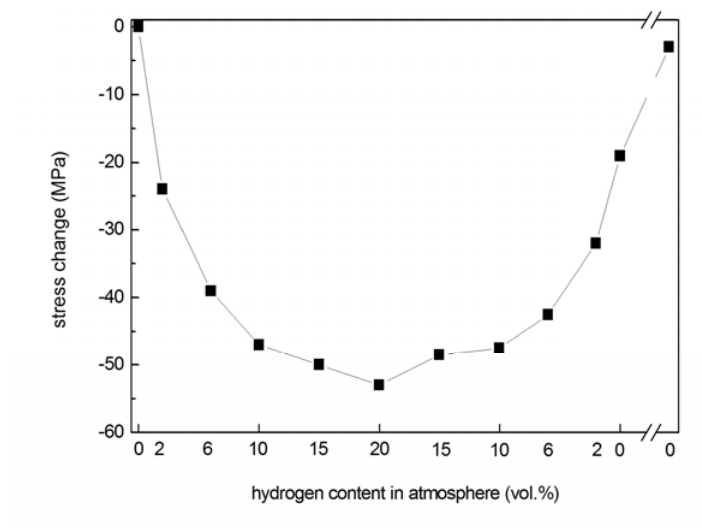
Figure 7. Hydrogen absorption/desorption behavior of a crack-free, 90 nm np-Pd film, produced from a precursor alloy with 22 at % Pd. Ambient hydrogen content was increased from 0% to 20% (by volume) and then decreased back to 0%. The np-Pd film stress became increasingly compressive with higher hydrogen content, and remained at a significant level after removal of hydrogen from the atmosphere. However, after 10 min in flowing nitrogen, stress returned to approximately the same value as that measured for the as-dealloyed film before exposure to